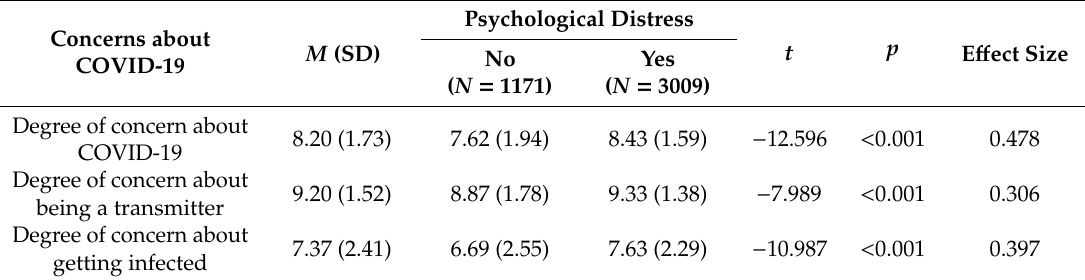
Table 4. Association between concerns about COVID-19 and psychological distress during the pandemic ( n =